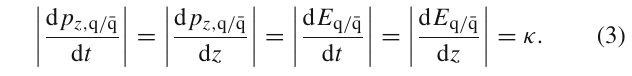
From the Hamiltonian, the equation of motion gives rise to a linear relation between the space–time and the energy– momentum